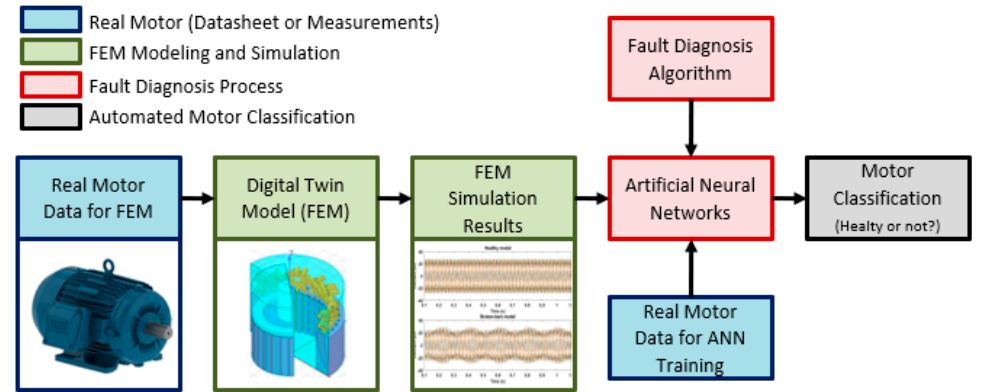
Figure 5. Block diagram for digital twin fault diagnosis. Table 3. ANN Parameters and accuracy for classification testing of the 3D FEM